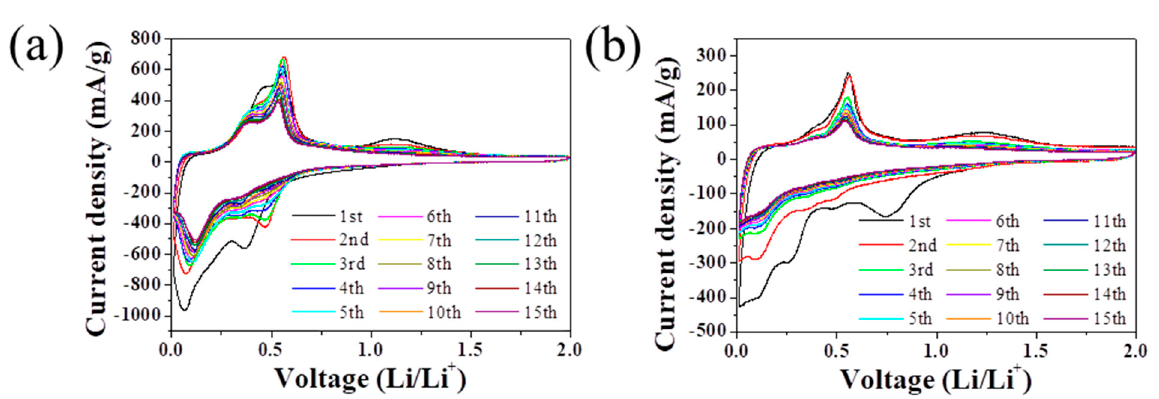
Figure 7. CV curves of ( a ) Ge/GeO 2 NPs and ( b ) Ge/RuO 2 nanocomposite at a scan rate of 0.1 mV s − 1